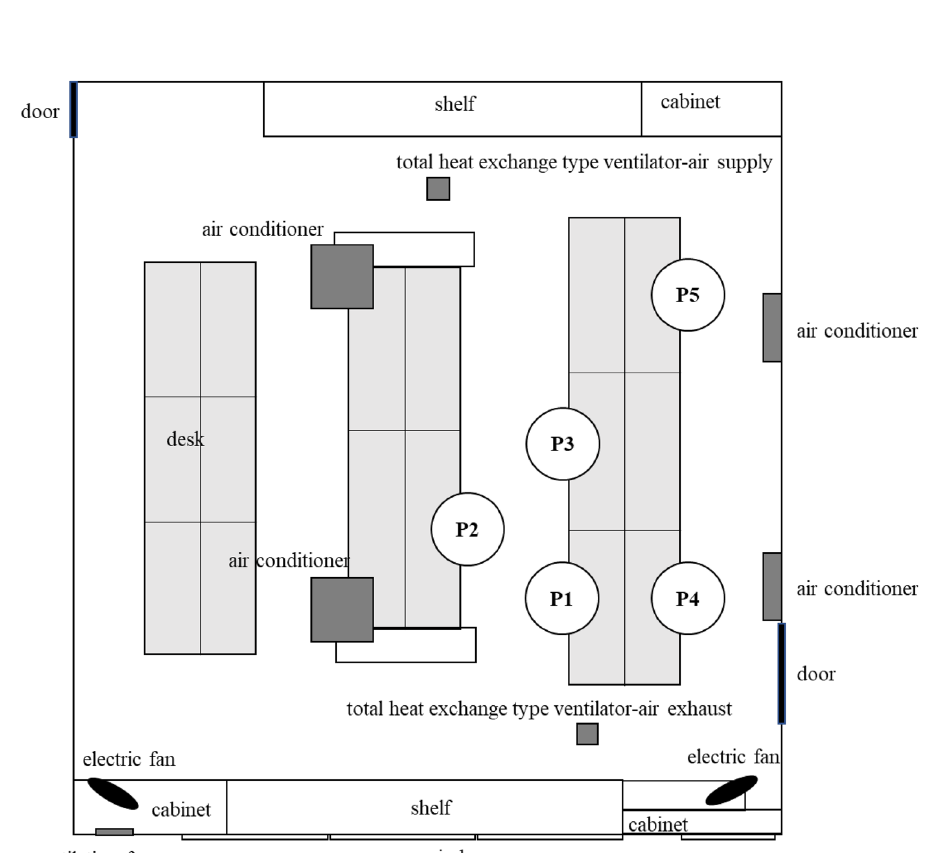
Figure 2. Desk placement of infected